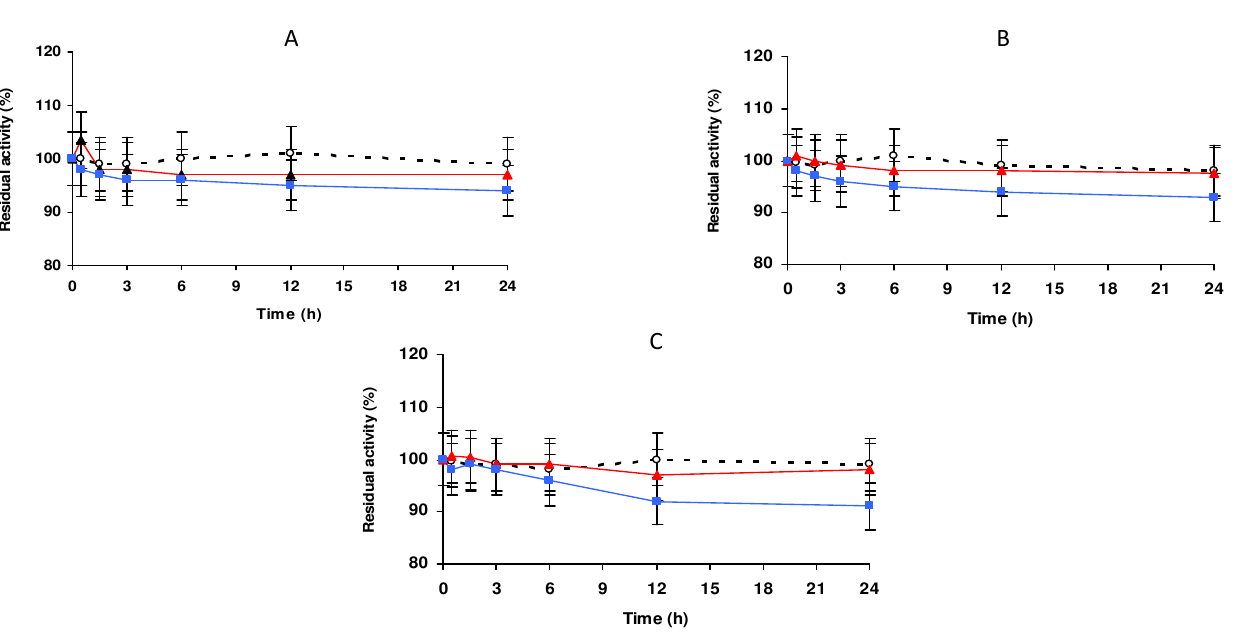
Figure 1. Effect of the pH in the immobilization courses of PGA on agarose-VS at 25 °C using 5 mM of the corresponding buffer. Data are shown as residual activity in %, considering 100% the initial activity. ( A ) Sodium acetate at pH 5.0, ( B ) sodium phosphate at pH 7.0, and ( C ) sodium carbonate at pH 9.0. Empty circles with dashed line: reference suspension. Red triangles: suspension. Blue squares: supernatant. Other specifications are described in the Methods Section.